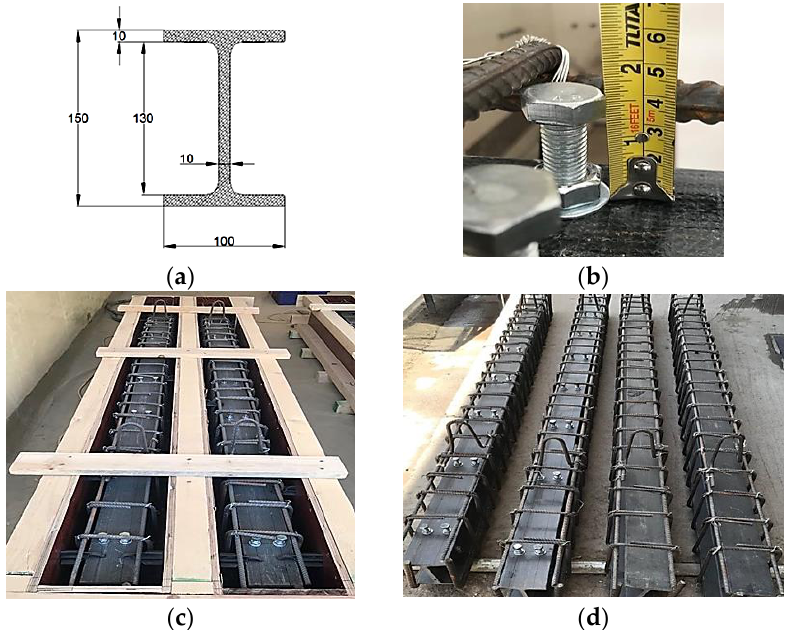
Figure 2. Details of the GFRP cross-section dimensions, studs, and reinforcements. (All dimensions are in mm). ( a ) Cross-section of GFRP I-beam. ( b ) Set of the shear connector. ( c ) GFRP I-beams with reinforcement. ( d ) GFRP I-beams with reinforcement and shear.